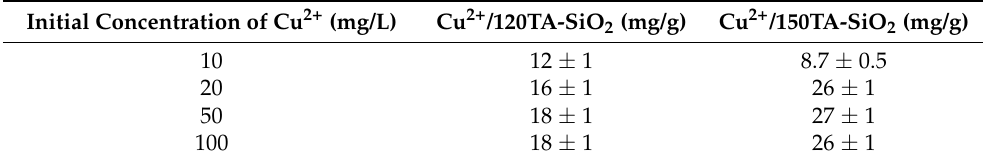
Table 5. Adsorption amount of copper as Cu 2+ /TA-SiO 2 (mg/g), detected by ICP-MS, at different Cu initial concentrations. Initial Concentration of Cu 2+ (mg/L)